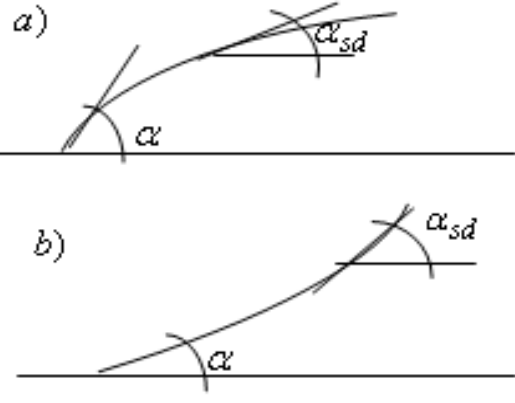
Figure 9. To the shift of the top of the Kelvin wave system. α : angle of entry of main waterline, α sd : angle of the tangent line to the main waterline in the top of the Kelvin bow system.